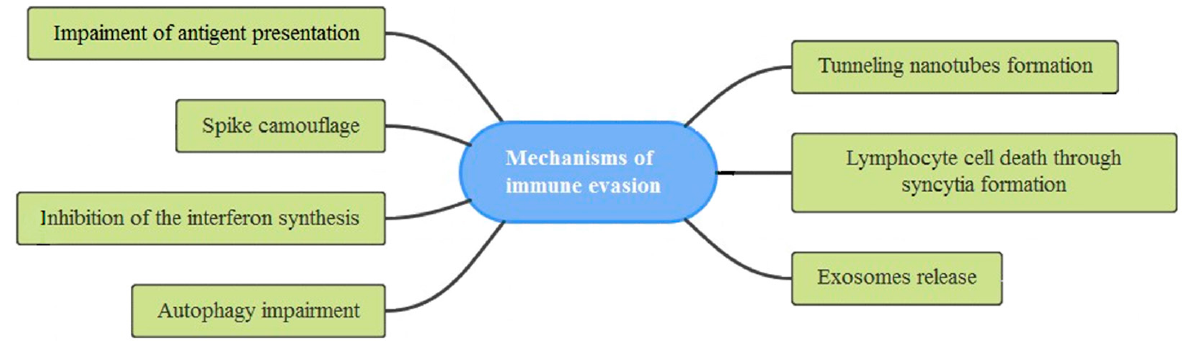
Figure 4. Schematic diagram showing the different evasion mechanisms developed by SARS-CoV-2 to avoid immune surveillance and attack by the immune system.